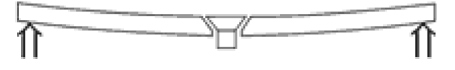
Fig. 7. A scheme showing how the sagging in the roof improves the runoff